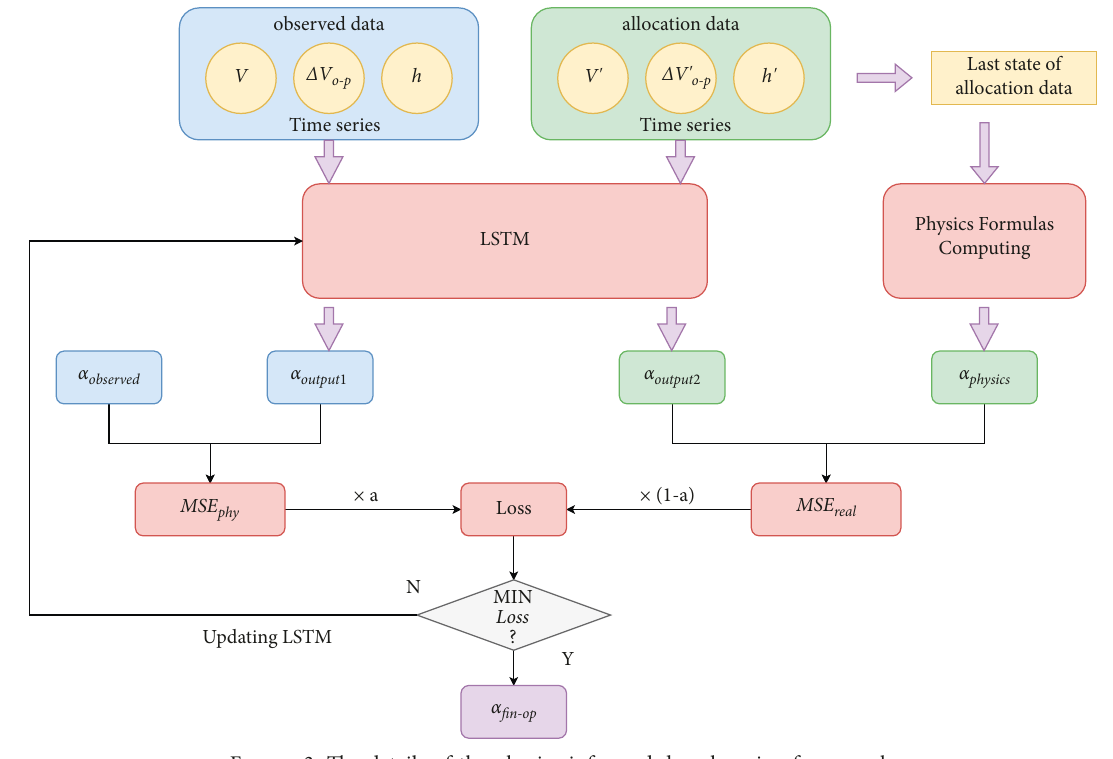
Figure 3: The details of the physics-informed deep learning